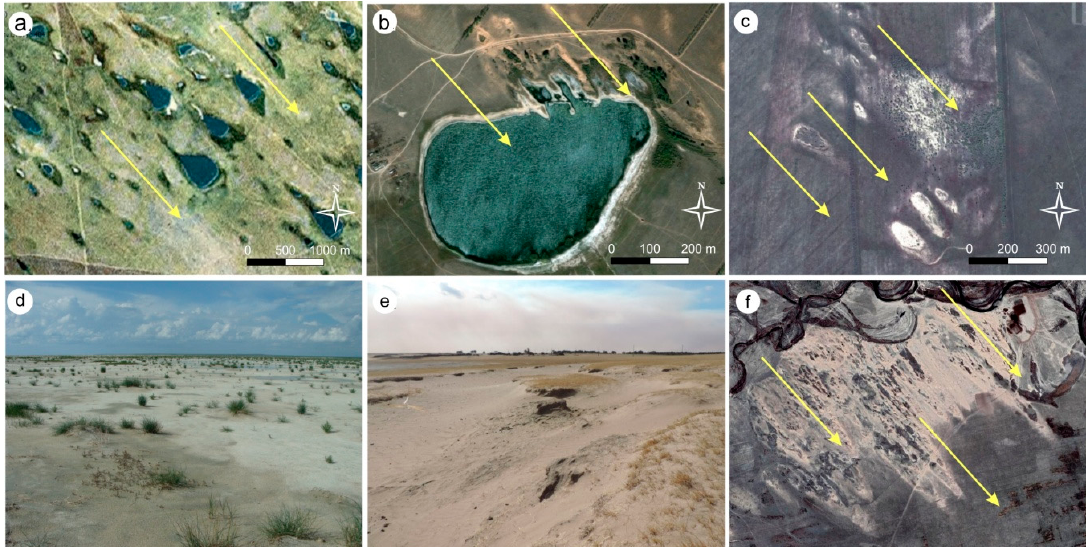
Figure 7. Morphologically pronounced traces of deflation and aeolian accumulation in Dauria: a — aeolian transfer of sediments of salt lakes in the Aginskaya steppe (Priononskaya Plain); b — deflation on the northern coast of the lake Big Yakshi; c —ancient dunes on the high terrace of the Onon river (Tsasucheiskii forest); d —aeolian processes of the bottom of the lake Barun-Torei in the dry period (July 2013); e —deflation basins on the northern coast of the lake Big Yakshi (spring 2014); f —drift sands in the south of the Onon river (the village of Chindant).